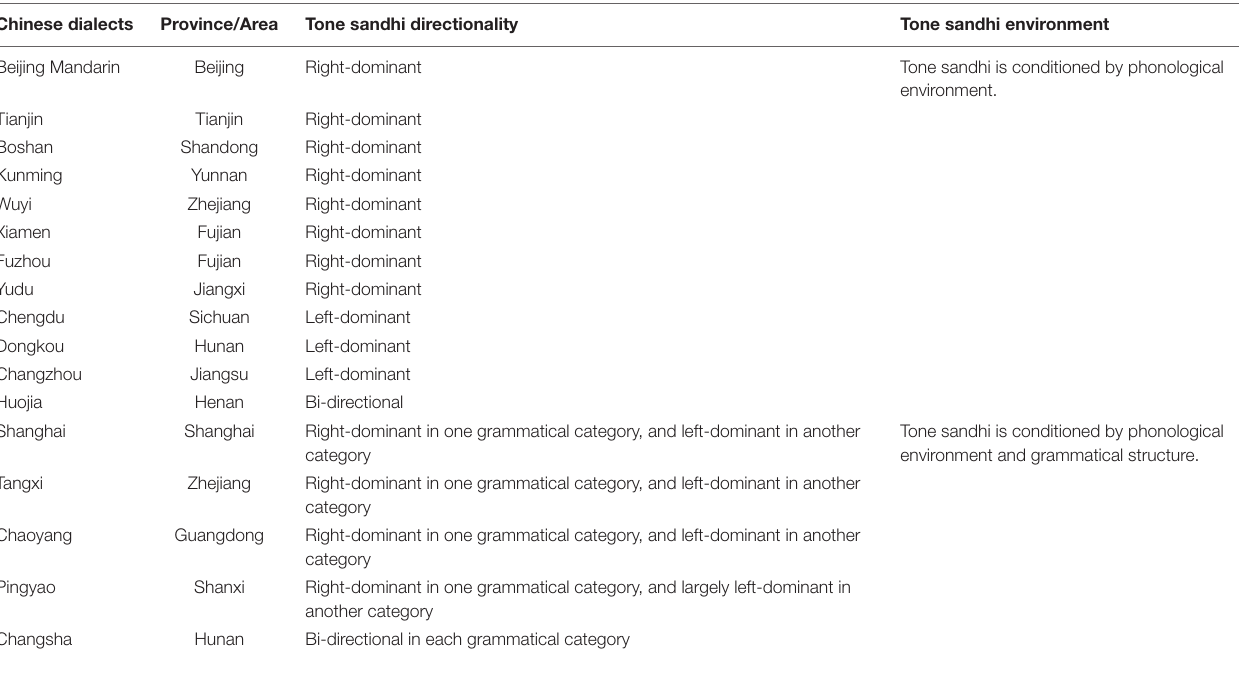
TABLE 1 | Tone sandhi directionality of 17 Chinese